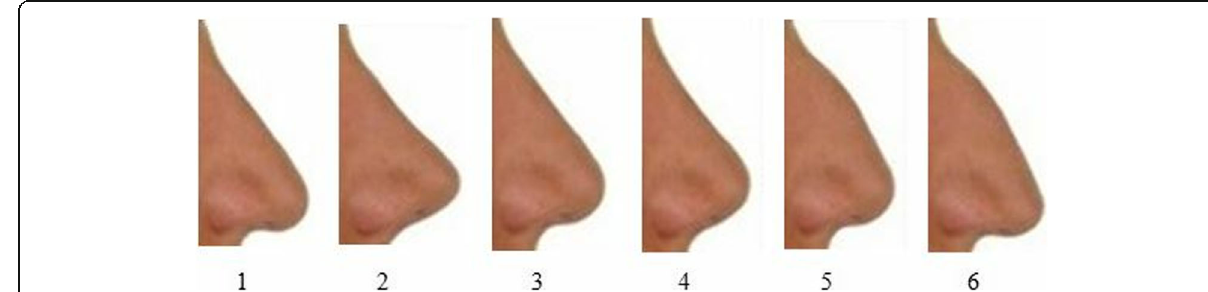
Fig. 4 Nose types used in the present